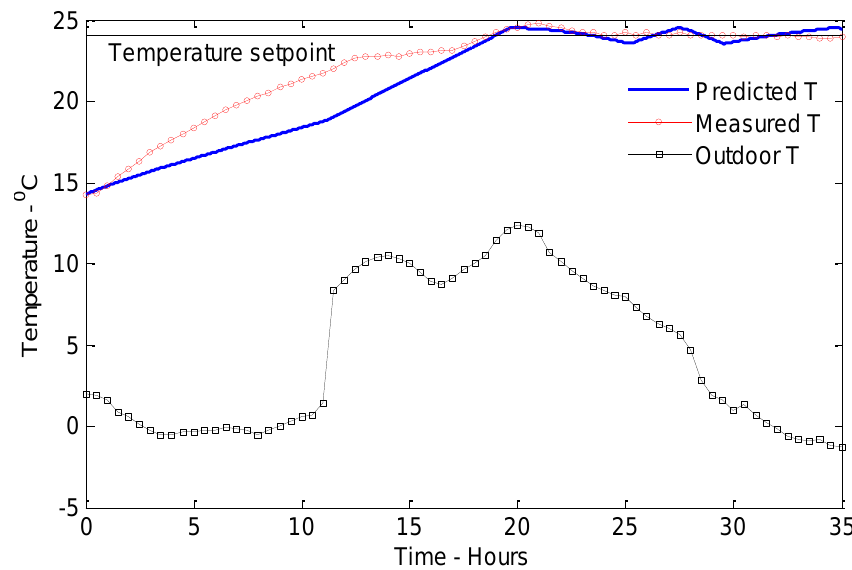
Figure 8. Variation of the internal and external air temperatures for Case 3.